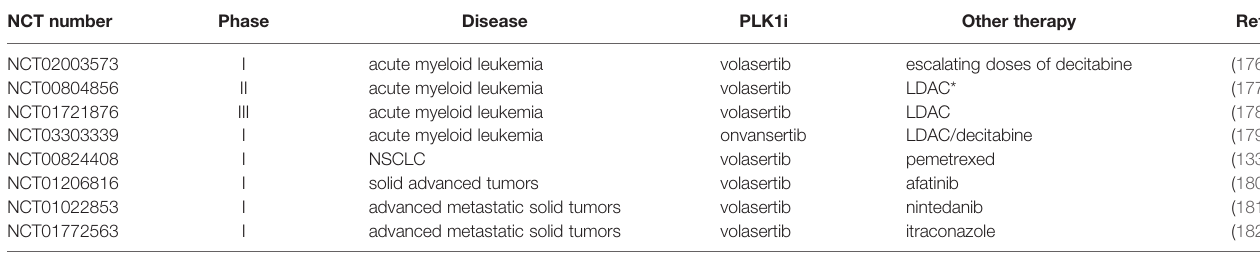
TABLE 3 | Clinical trials based on PLK1 inhibition combination therapy.